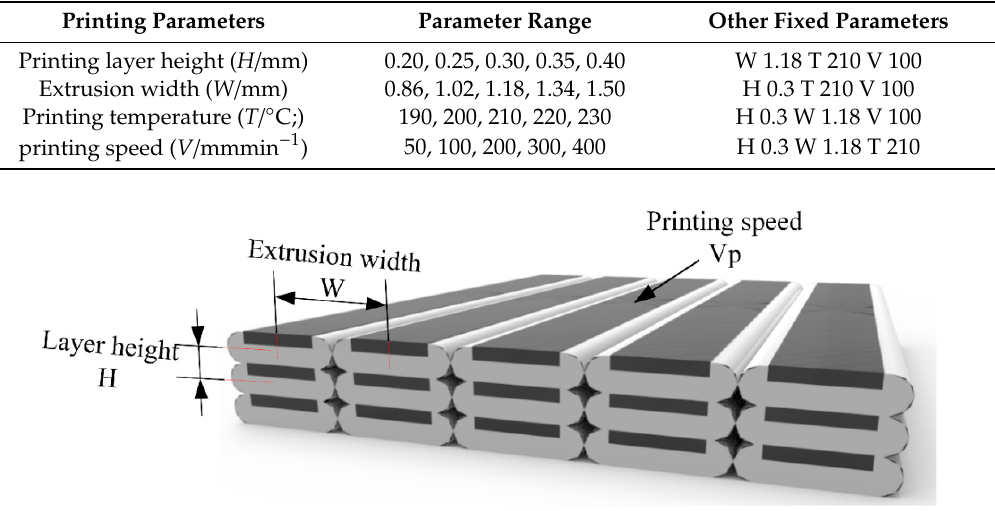
Table 2. Parameters of the carbon fiber-reinforced 3D printing tensile specimen.